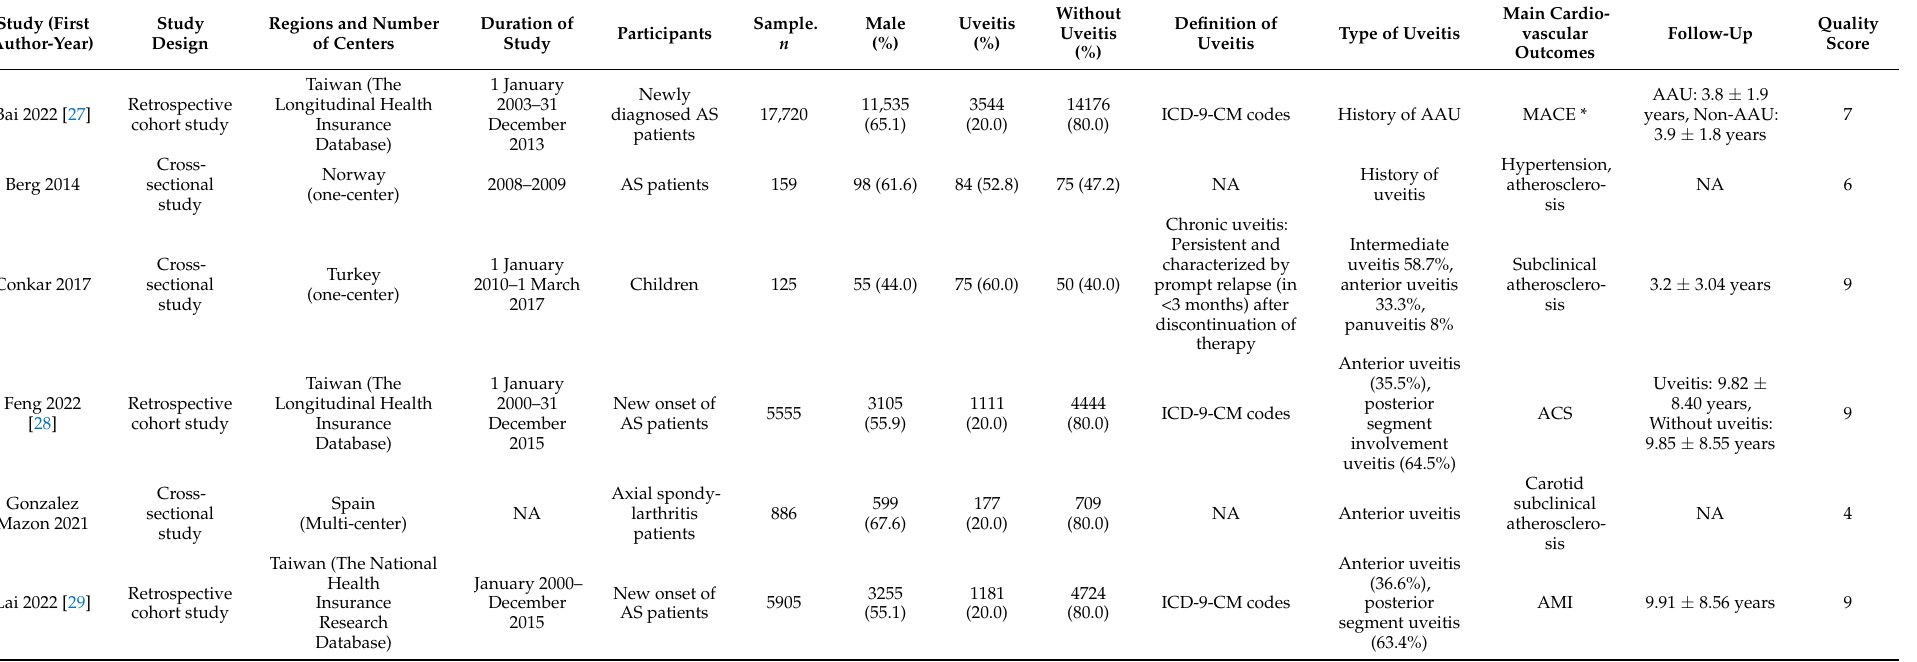
Table 1. Characteristics of the included